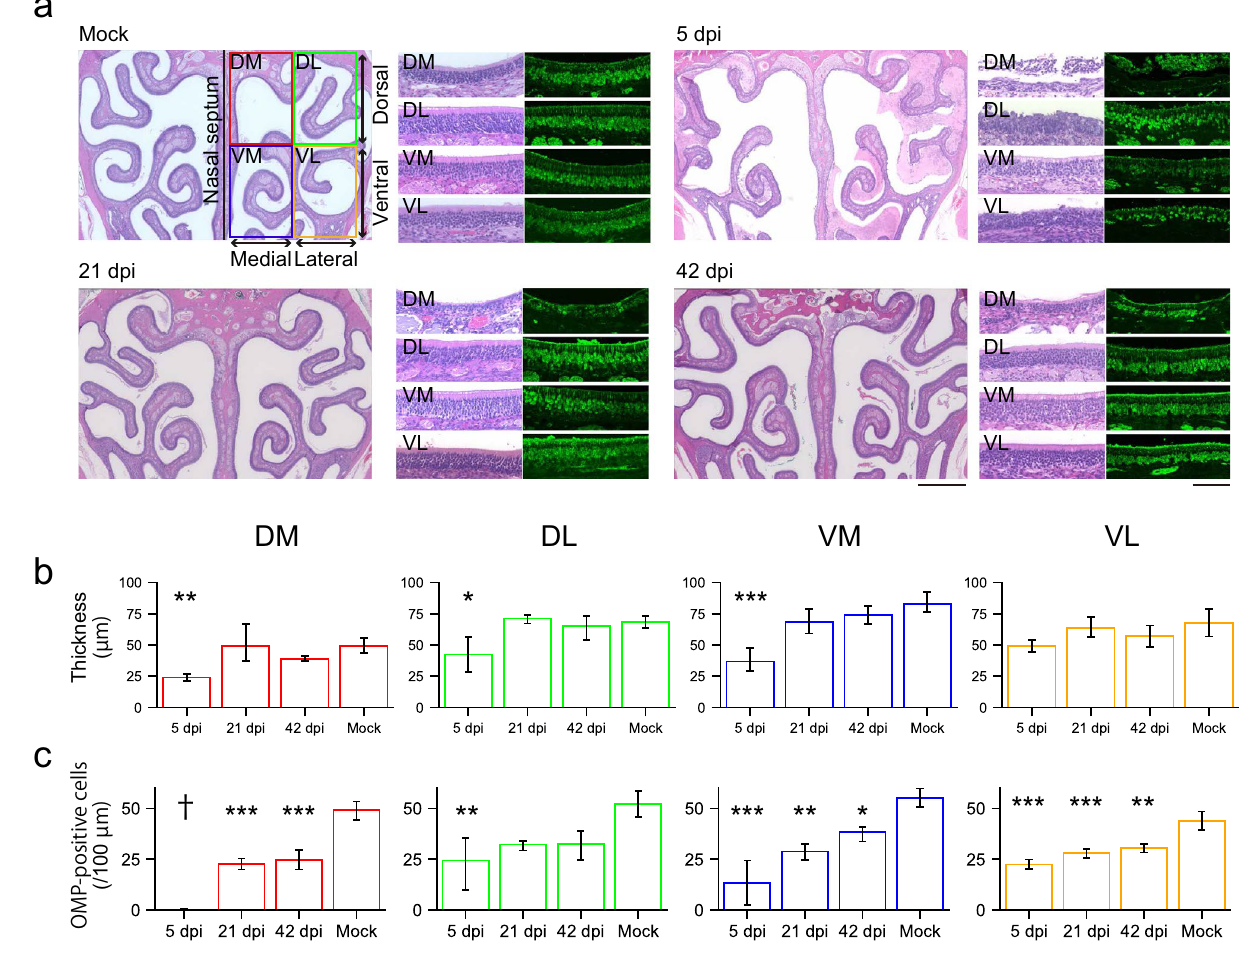
Figure 3. Cellular properties in the OE due to SARS-CoV-2 infection. (a) Representative images of the OE stained with HE and OMP at 5 dpi, 21 dpi, and 42 dpi and mock,. Scale bars, 1 mm (left), 100 μm (right). (b) The thickness of the OE in 4 subdivided areas at 5, 21, and 42 dpi and mock; DM, DL, VM, and DL (one-way ANOVA followed by Dunnett’s post hoc test. *p < 0.05, **p < 0.01, ***p < 0.001). Number of samples; n = 3 (21 dpi) and 4 (5, 42 dpi, and mock). (c) Numbers of the OMP-positive cells in the neuroepithelium at 5, 21, and 42 dpi and mock; DM, DL, VM, and DL. (n = 3, one-way ANOVA followed by Dunnett’s post hoc test. *p <